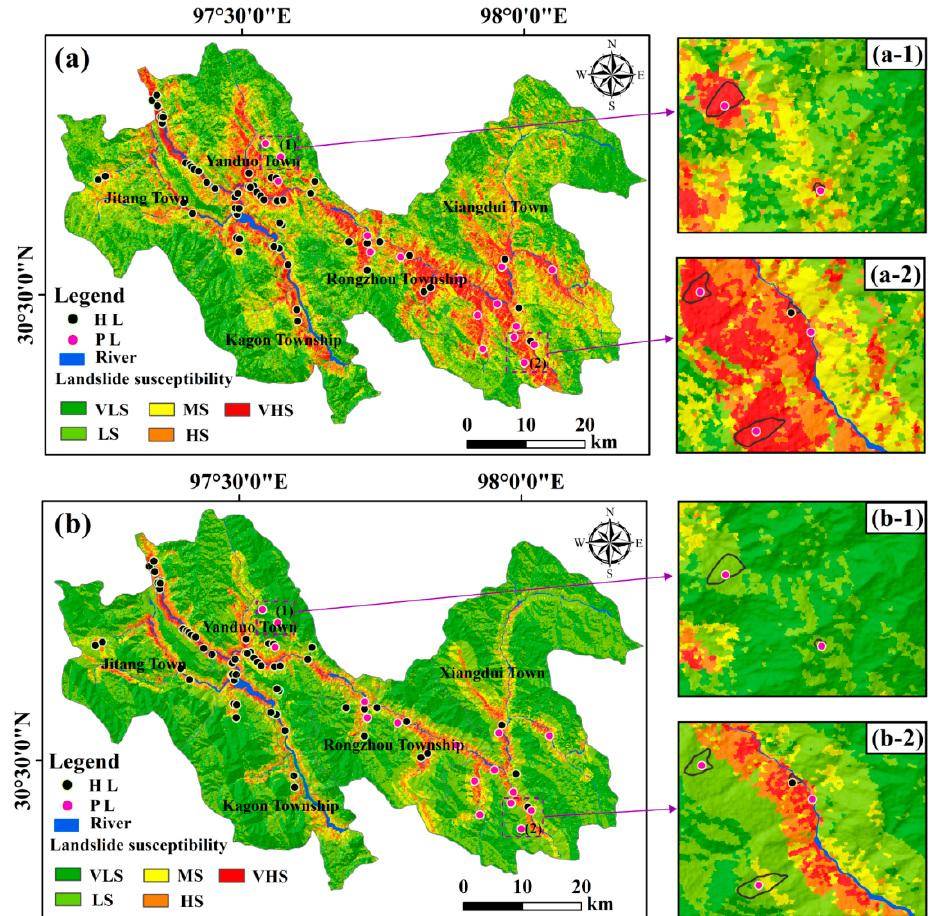
Figure 12. Comparison with the landslide susceptibility evaluation (LSE) only according to known landslides. ( a ) LSE map generated from known and potential landslides. ( b ) LSE map produced from known landslides. See Figures 5 and 8 for the meaning of the legend.